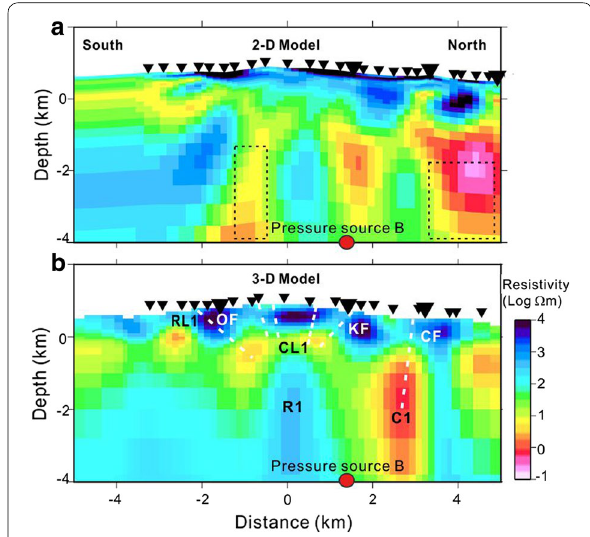
Fig. 5 Vertical slices of resistivity structure. a 2-D model. Inverted black triangles indicate observation sites used in the inversions. White dashed ellipses mark the low-resistivity zones that are not produced in the 3-D inversion. b 3-D model. RL1 (resistive layer 1), CL1 (conductive layer 1), R1, and C1 are the features discussed in Sects. 2-D and 3-D inversions and